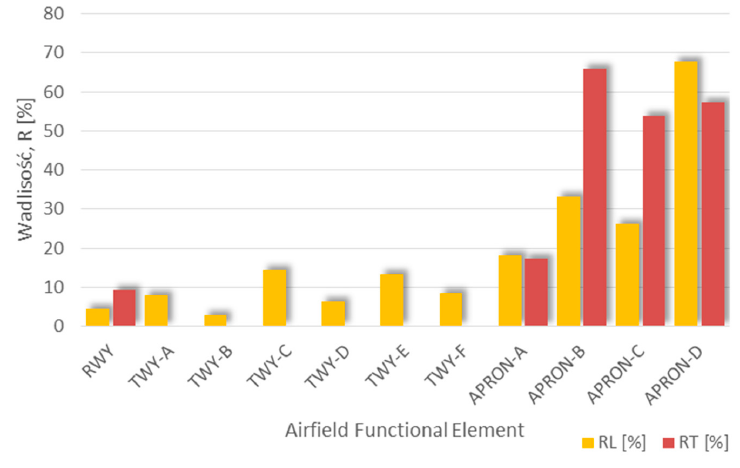
Figure 12. Test results of the pavement evenness.